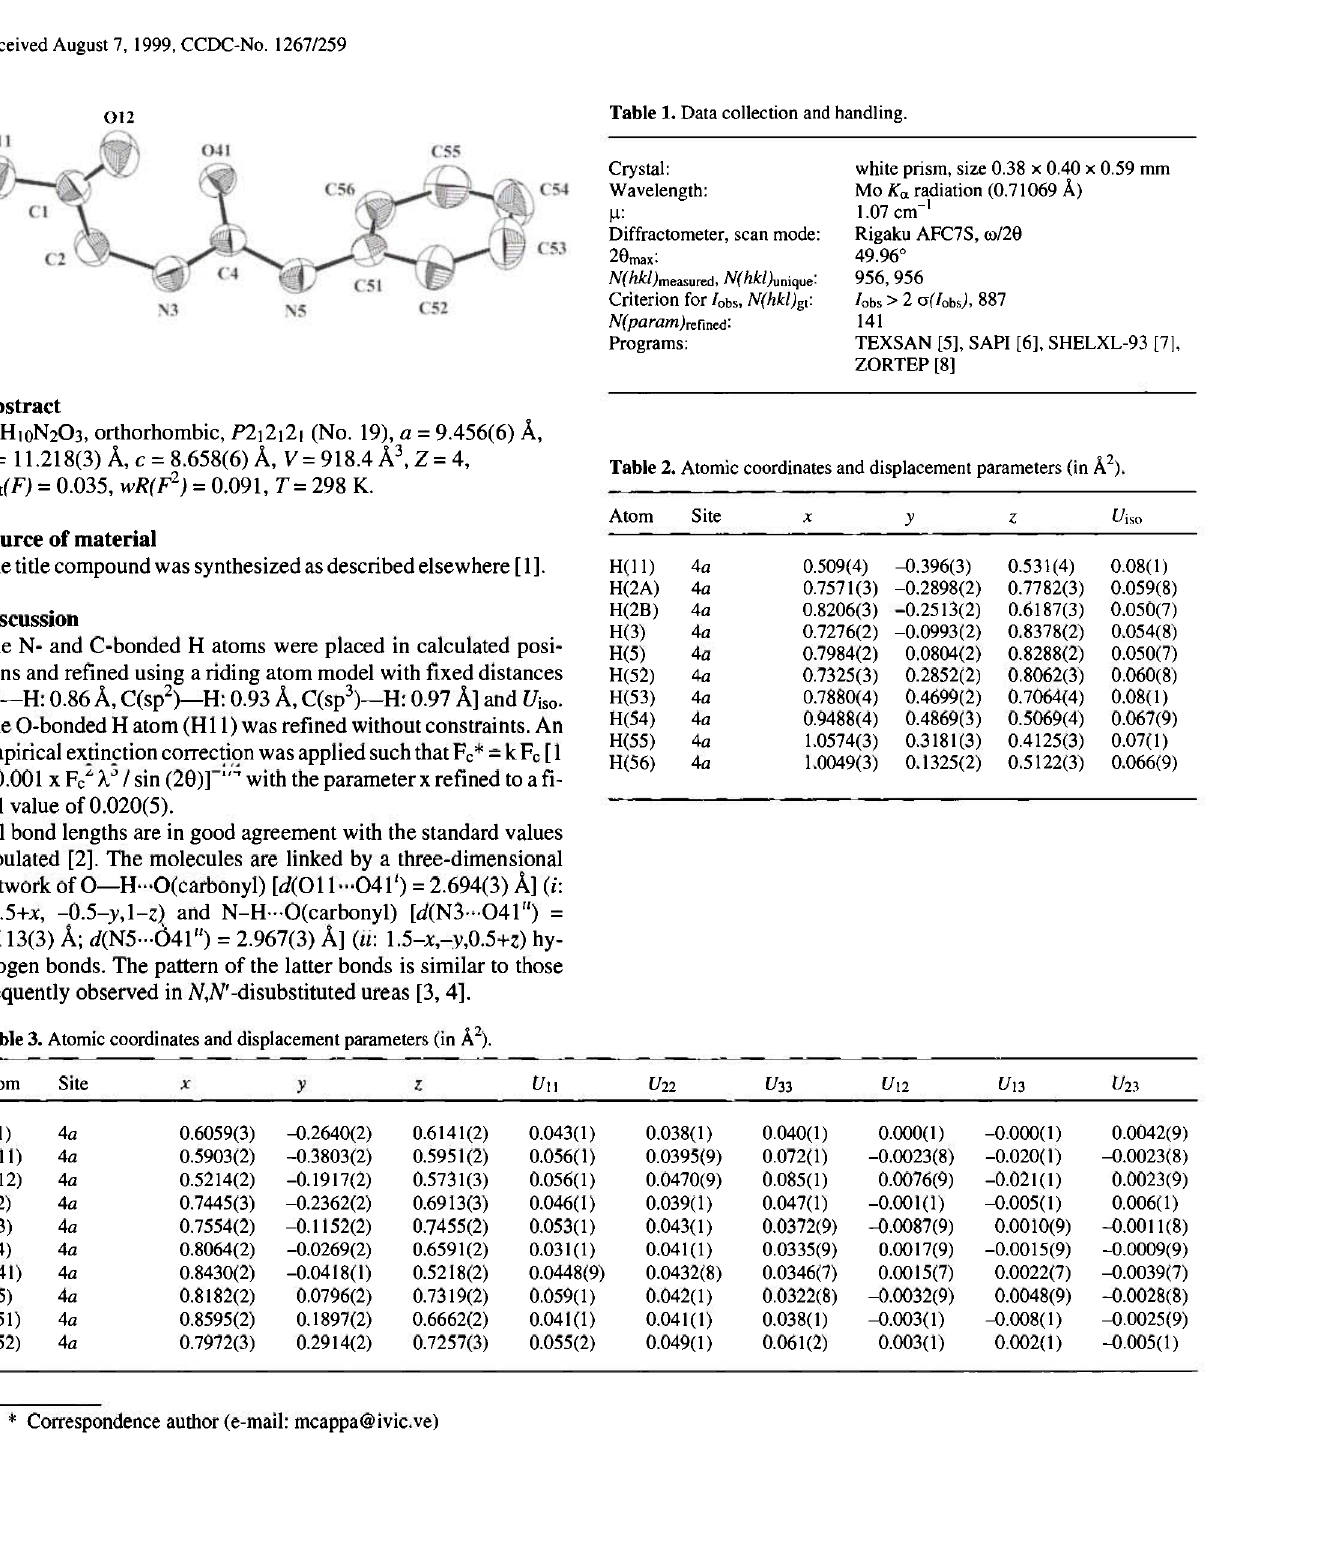
Table 1. Data collection and handling.